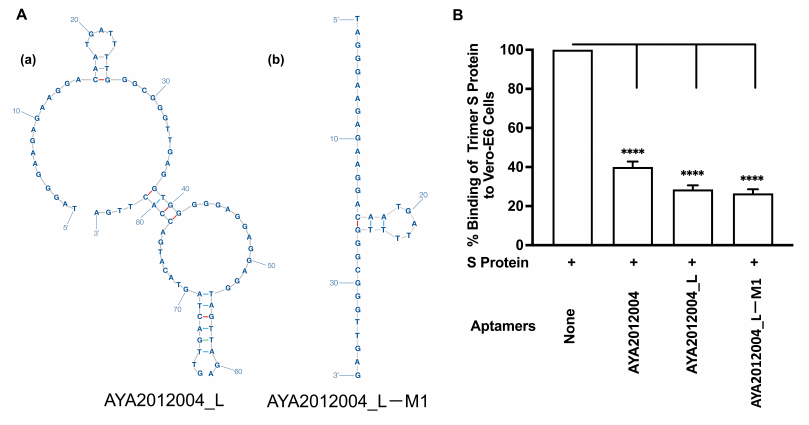
Figure 6. Characterization of modified aptamers. ( A ) Aptamers modification. The predicted sec- ondary structures of ( a ) AYA2012004_L, ( b ) its truncated modification AYA2012004_L-M1. The sec- ondary structure analysis of AYA2012004_L was performed using the mfold webserver. The default environment was used for folding, which includes 37 ◦ C as the folding temperature and 0.2 M of Na + . The secondary structure of AYA2012004_L as well as its truncated modification AYA2012004_L-M1 are shown. The truncation was performed by removing the big loop (nucleotides from position 38 to 85) from the AYA2012004_L. ( B ) Cell-based binding assay of SARS-CoV-2 S-protein trimer to ACE2 expressing Vero E6 cells in the absence or presence of the modified aptamers. His-tagged SARS-CoV-2 trimer S protein (10 nM) was incubated with Vero E6 cells in the absence or presence of the indicated aptamers (5 µ M). After 1 h incubation, unbound S-protein was washed out, and the cell pellet was solubilized with 1% Triton X100 for 1 h. Supernatant containing solubilized S protein was applied to the nickel-coated plate. The His-tagged trimer S protein bound to nickel was detected using mouse monoclonal antibodies against S protein. Each value was the average of duplicate measurements. Error bars represent mean ± SD ( σ ). The p -values were determined with one-way ANOVA and Dunnett’s multiple comparison test. **** denotes p < 0.0001.